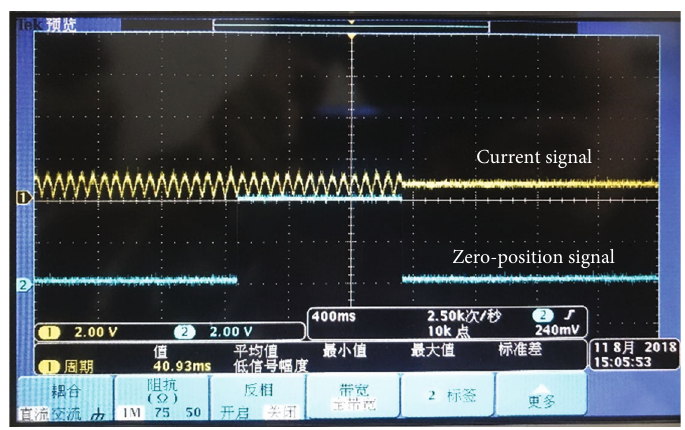
Figure 14: Wave of current and zero-position